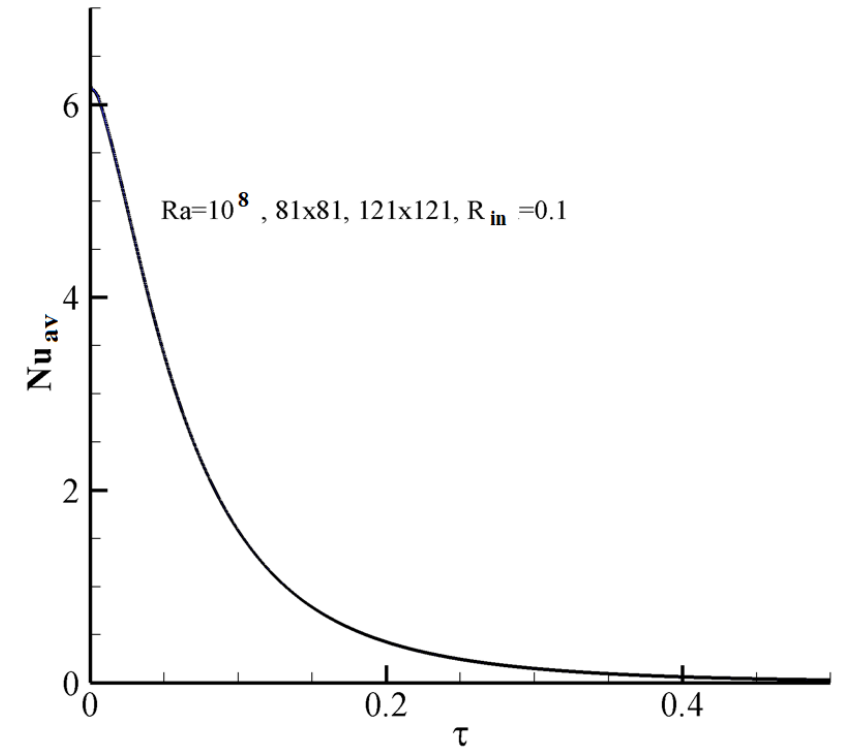
Figure 2. Grid independence test for Ra = 10 8 and R in = 0.1.